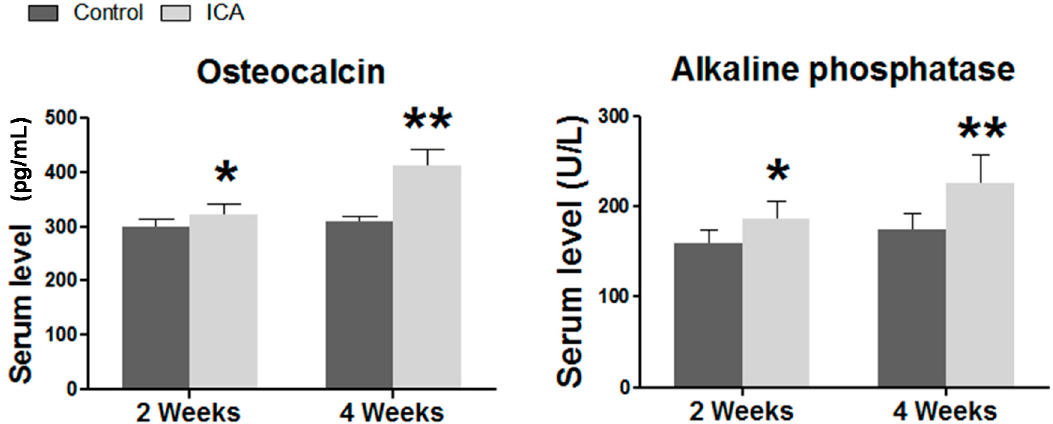
Figure 2. Serum chemistry. The results of ELISA showed that the application of ICA significantly enhanced osteogenesis. The expression of alkaline phosphatase (AP), and osteocalcin (OCN) in the ICA group were significantly increased at two and four weeks postoperatively. * p < 0.05 vs. the control group; ** p < 0.01 vs. the control group.